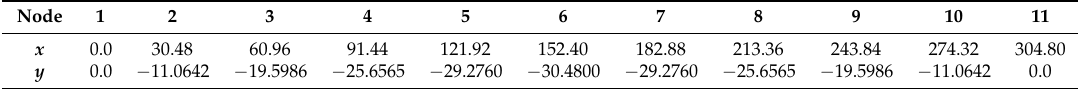
Figure 3. A single span cable subjected to multiple concentrated loads. Table 4. Node coordinates of cable segments at initial state (unit: m).